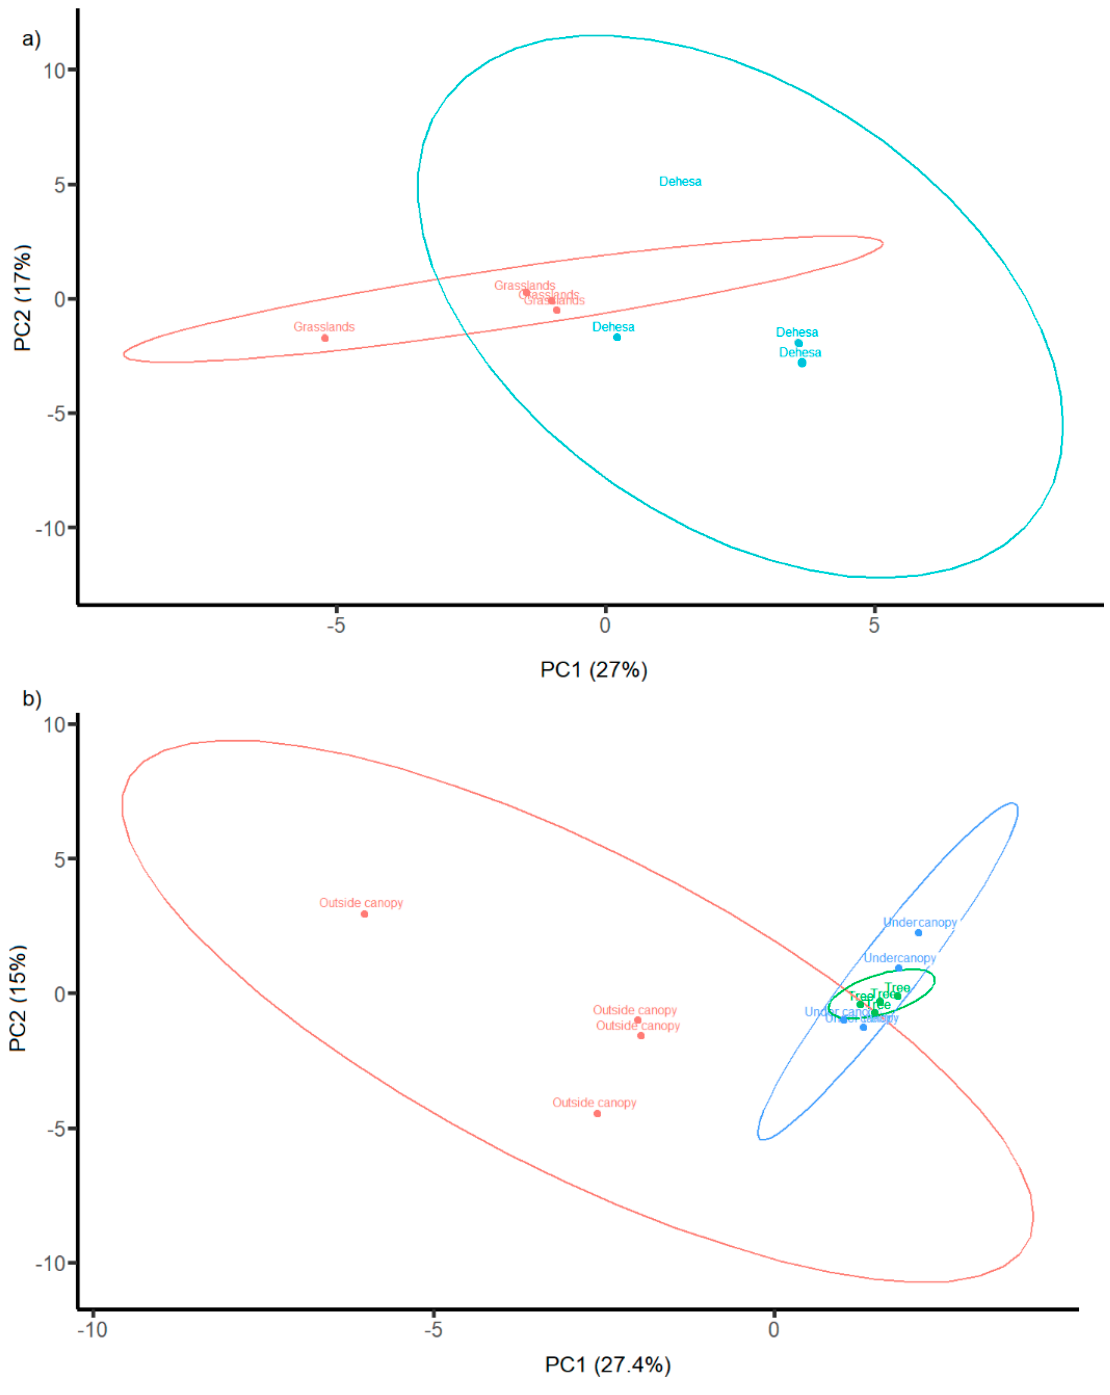
Figure 4. Principal Component Analyses comparing the ant communities from ( a ) grasslands and dehesas and ( b ) within dehesas : outside canopy, under canopy, and in the trunk.